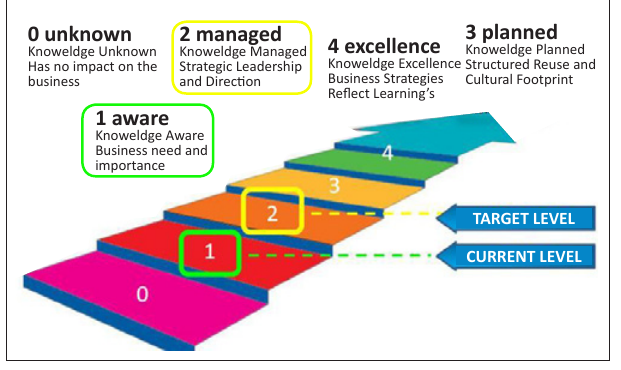
FIGURE 7: Maturity level of